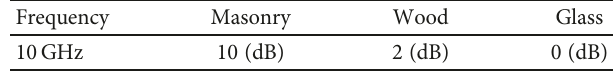
Table 3: Loss per wall for 10 GHz indoor measurement campaign.